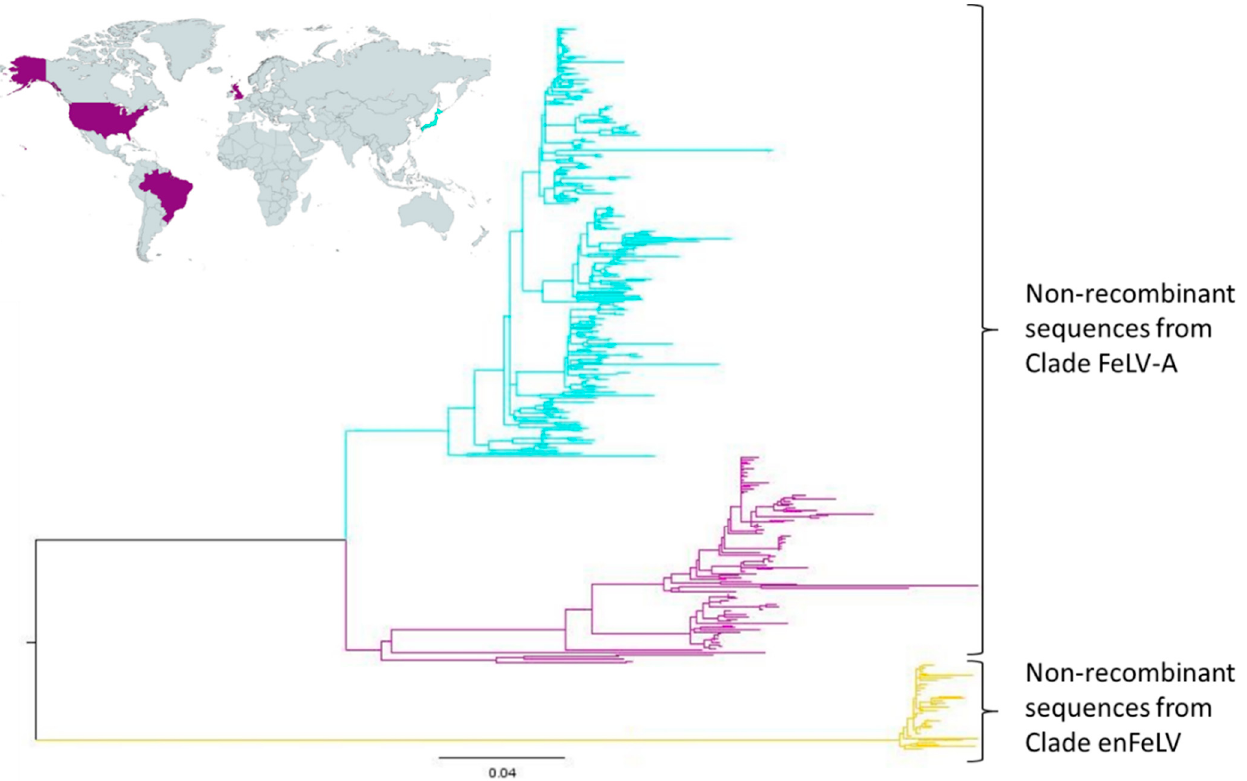
Figure 4. Phylogenetic reconstruction of the non-recombinant FeLV SU sequences and geographical distribution of the clade FeLV-A. Maximum likelihood tree reconstructed by incorporating the best-fitted nucleotide substitution model (GTR+F+R5) in IQtree web server. The robustness of the resulting tree was evaluated by rapid bootstrapping (UFB) with 1000 pseudoreplicate datasets. The phylogenetic tree was visualized in FigTree v1.4.4 [34] and drawn using R [35]. Three main clades are presented. The yellow clade corresponds to non-recombinant sequences from clade enFeLV and the blue and purple to the non-recombinant sequences from clade A (Figure 1).